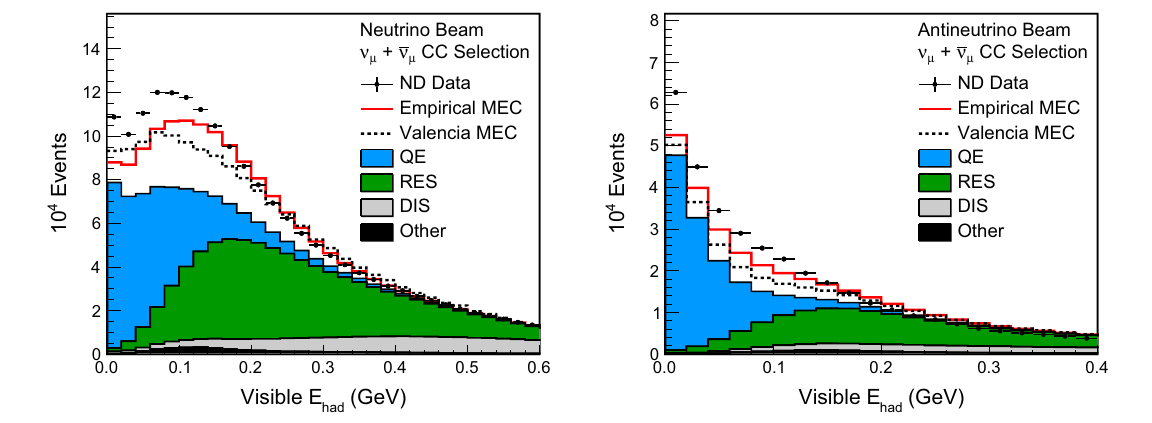
beam(left)andantineutrinobeam(right).Thefilled,stackedhistograms indicate the non-MEC components of the prediction, to which all the modifications described in Sect. 4 have been